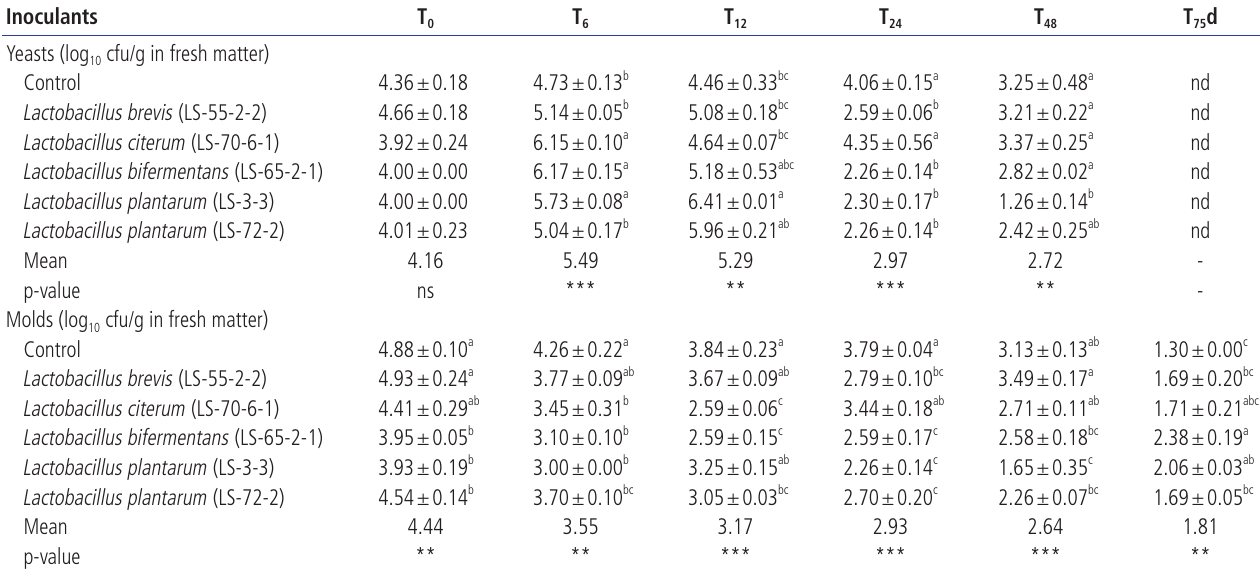
Table 4. Effects of different bacterial inoculants on numbers of yeasts and molds of ensiled silages at different silage opening times Inoculants